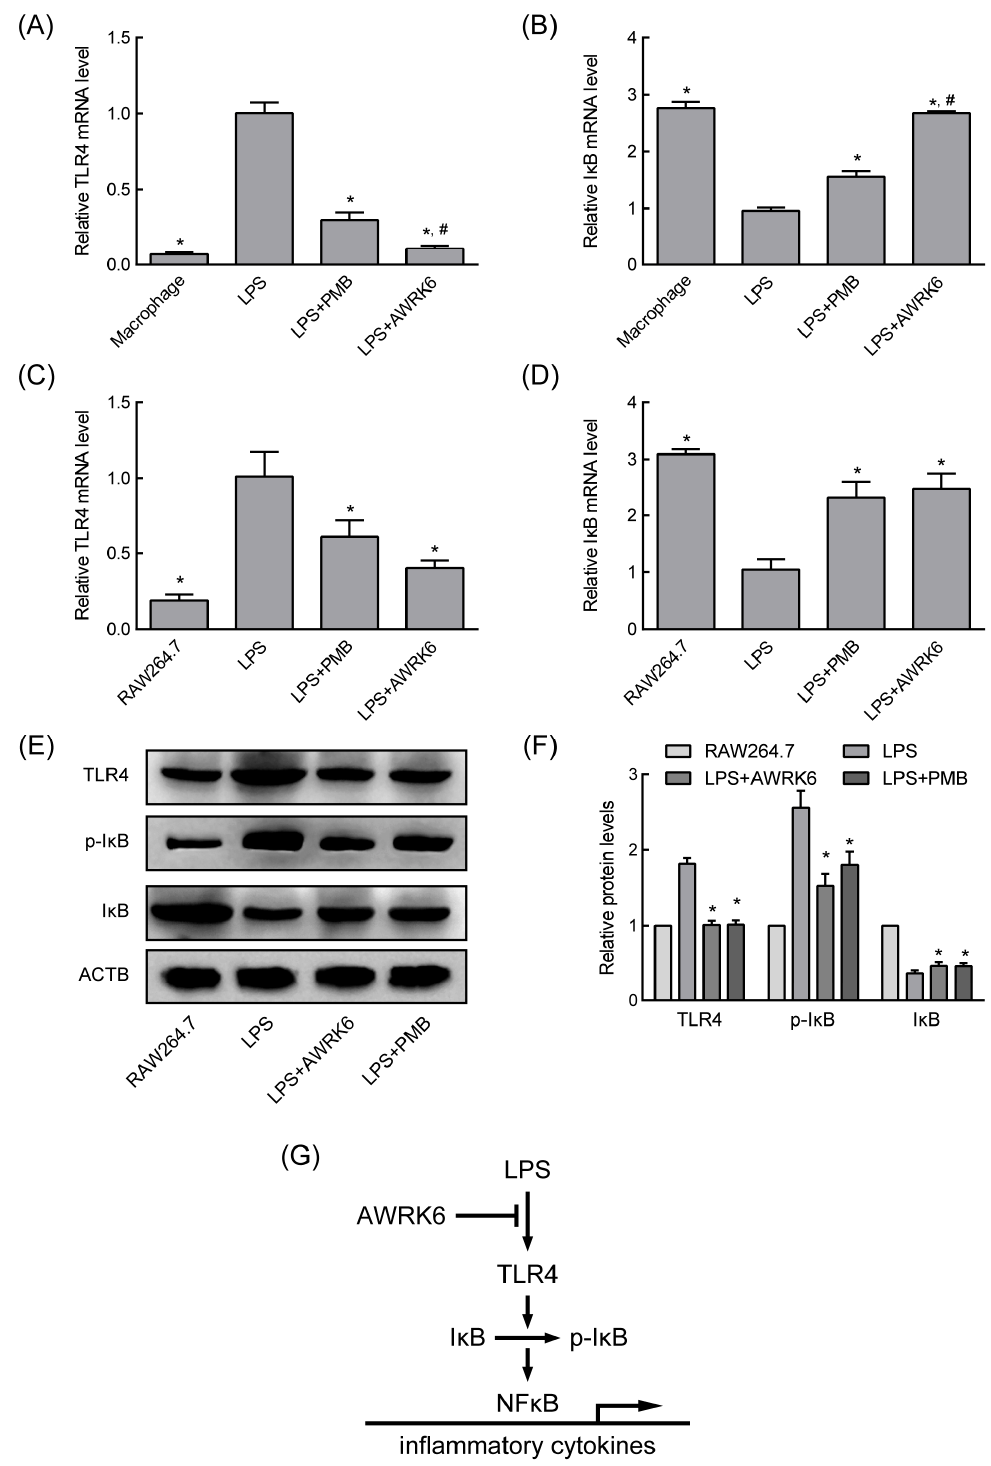
Figure 4. AWRK6 relieved LPS-induced systemic immune response by blocking TLR4/NF- κ B activation. ( A , B ) The mRNA levels of two genes involved in immune response, TLR4 and I κ B in primary macrophages were analyzed by real-time PCR. ( C , D ) The mRNA levels of TLR4 and I κ B in RAW 264.7 cells were analyzed by real-time PCR. ( E ) The expression of TLR4, I κ B, and p-I κ B was detected by Western blotting. ( F ) The quantification of Western blotting was applied with ImageJ. ( G ) AWRK6 inhibited LPS-induced immune response by blocking TLR4/NF- κ B activation (the arrows indicate induction and T bar indicates inhibition). * p < 0.05 compared with LPS group, # p < 0.05 compared with the LPS + PMB group.